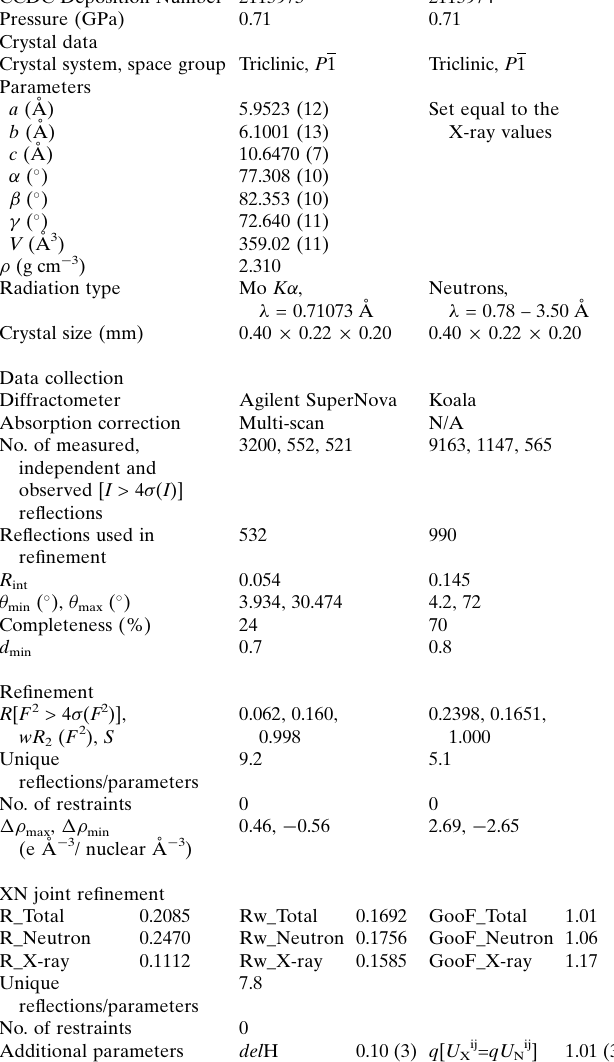
Table 4 Crystallographic information for copper sulfate pentahydrate at 0.71